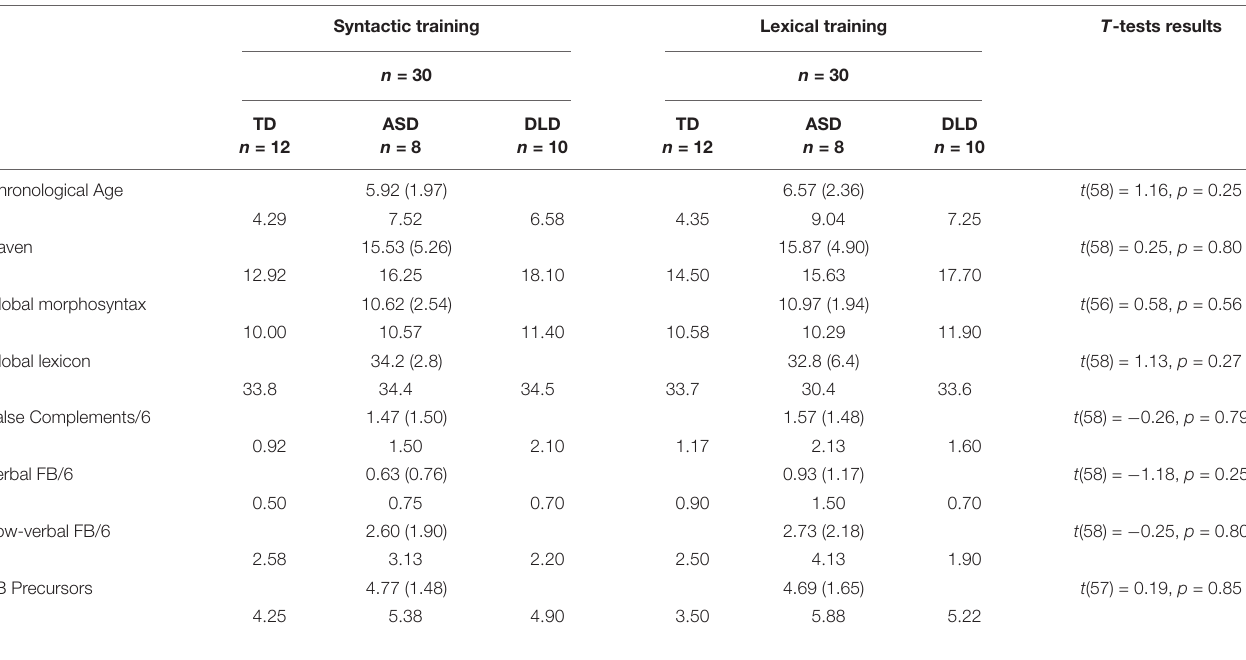
TABLE 1 | Means (standard deviations) on paired variables at the moment of pre-test for the two groups (syntactic training, lexical training) and the three populations of children (TD, Typically Developing; ASD, Autism Spectrum Disorder; DLD, Developmental Language